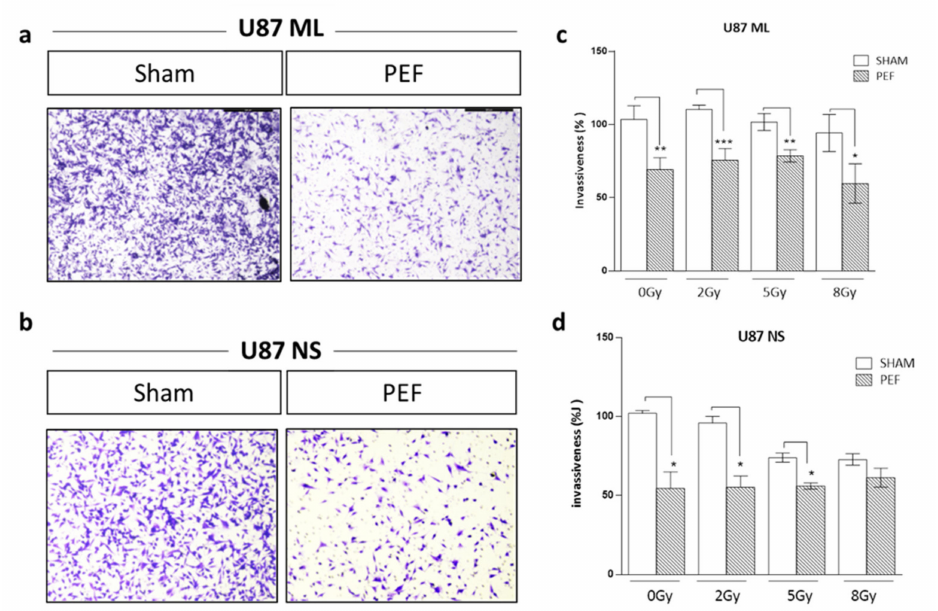
Figure 6. Invasion and migration assay. Representative images of transmigrated cells for ( a ) U87 ML and ( b ) U87 NS cells. ( c , d ) Percentage of invasiveness in U87 ML and NS cells evaluated 24 h after PEF-5 exposure and IR combined treatment. p values were determined using a two-tailed t test. * p < 0.05; ** p < 0.01; *** p <